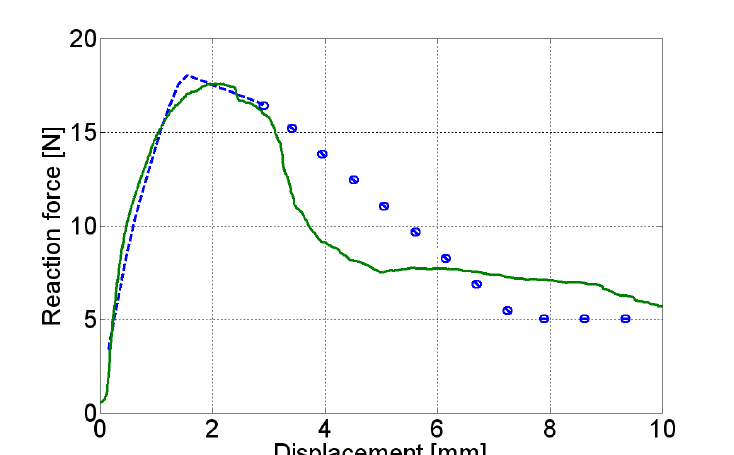
Figure 12: Graphical representation of the experimental output compared with the load − displacement curve reconstructed by the parameter values listed in Tab.